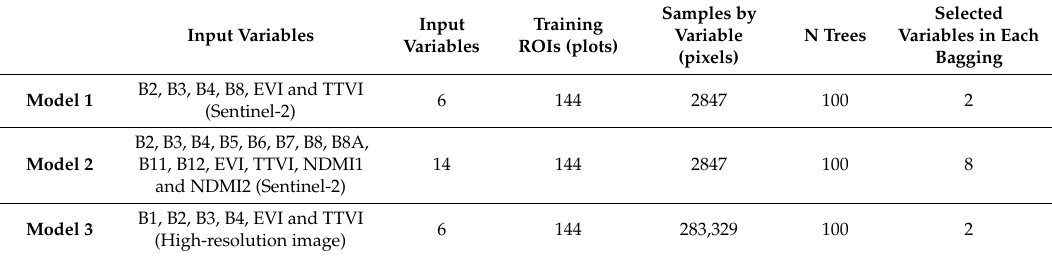
Figure 5. Convergence of the generalization error of the models. The models were trained with an increasing number of decision trees, and the accuracy of classification was evaluated from the pixel-based classification. The convergence of the three models occurred at around 100 decision trees. Images ( a ), ( b ) and ( c ) show the convergence of Models 1, 2 and 3, respectively. Table 2. Summary of the parameters used in each model.